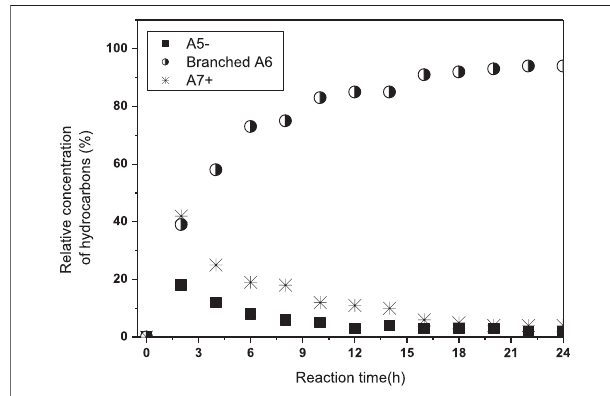
FIGURE4| Relativeconcentrationofsomeproducts,intheliquidphase, obtained from 5 g DX/90 g n-hexane using 10 g Pd/HBEA at 250 ° C under 30 bar pf H 2 for 24 h. A5 − (cid:1) alkanes with fi ve or fewer carbons. Branched A6 (cid:1) branched alkanes with six carbons; A7+ (cid:1) alkanes with seven or more carbons.